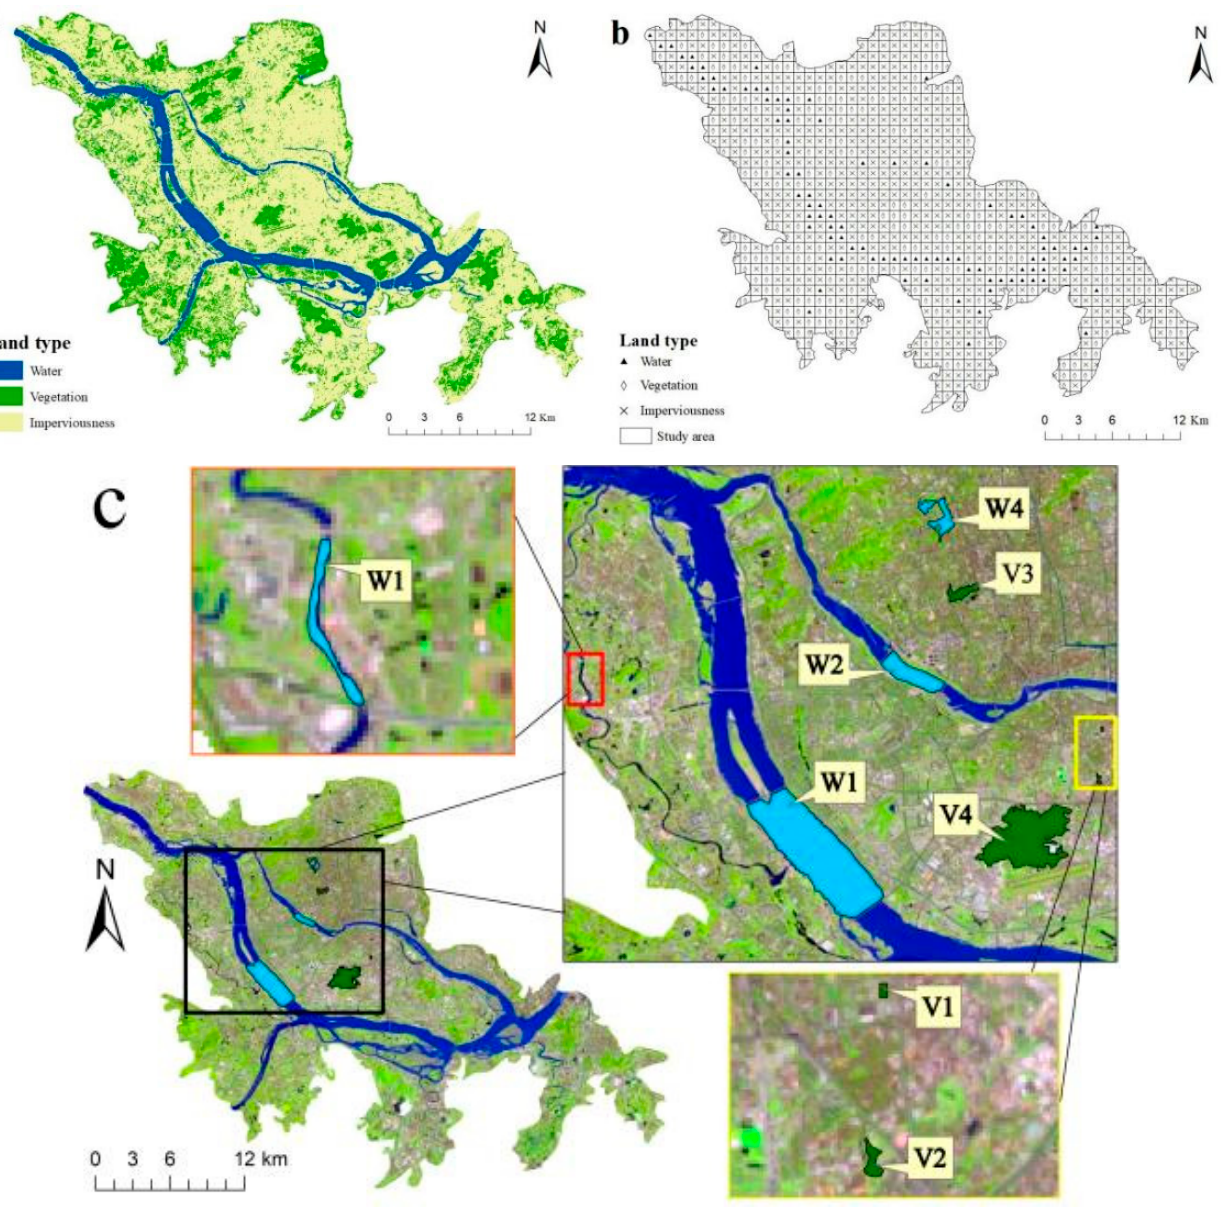
Figure 2. Land type and patch location in the study area. ( a , b ) are land types of urban underlays; ( c ) is patch location map of water and vegetation. Wi is the extracted water patch, Vi is the extracted vegetation patch. Table 1. Water and vegetation patch sample information.